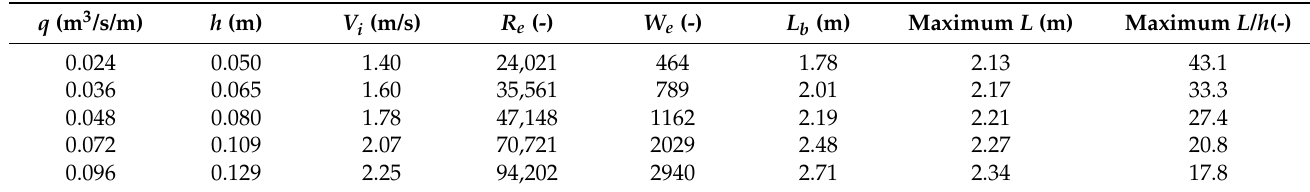
Table 1. Characteristics of the tests at the issuance